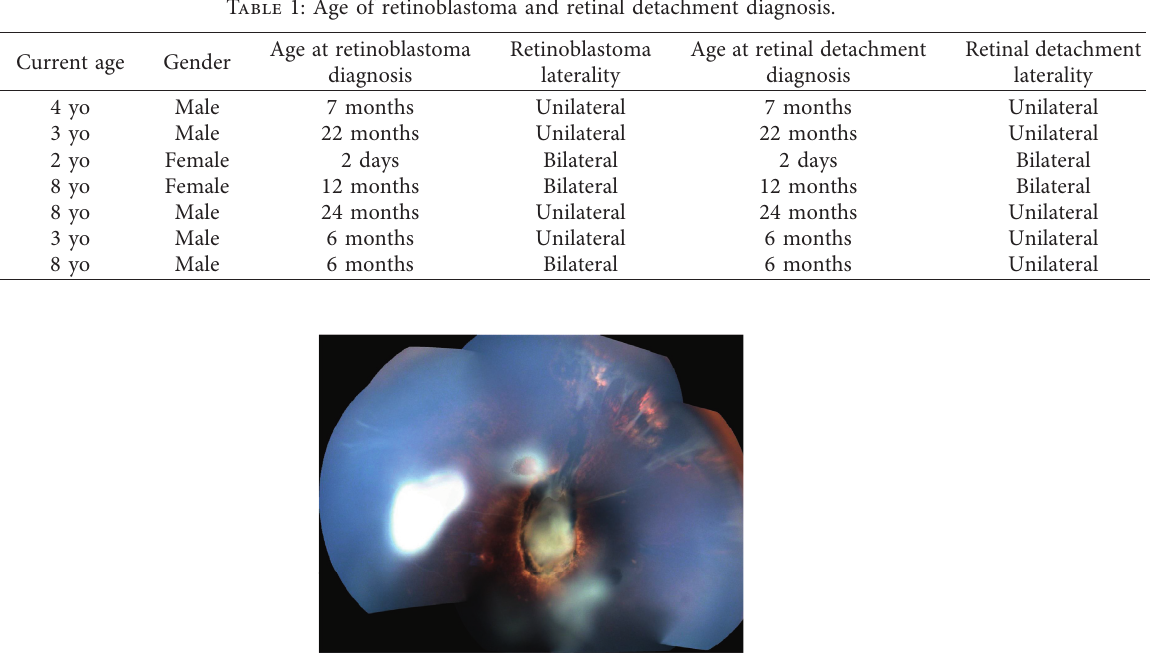
Figure 2: Patient 2 with treated retinoblastoma and persistent tractional retinal detachment associated with persistent fetal vasculature in the right eye.